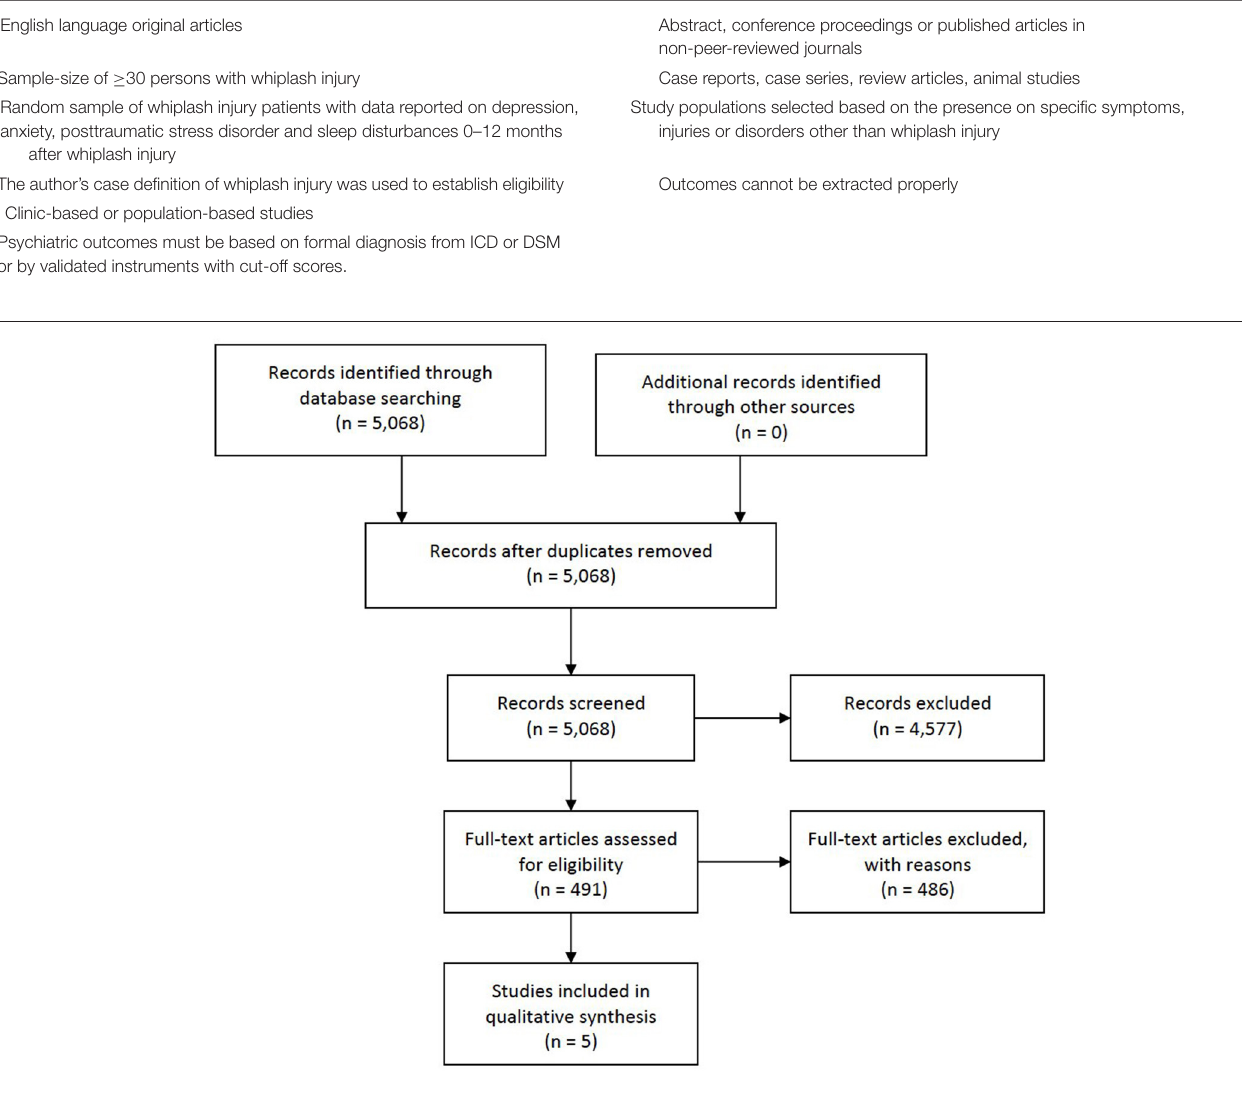
FIGURE 1 | Flow diagram. Psychiatric outcomes following whiplash